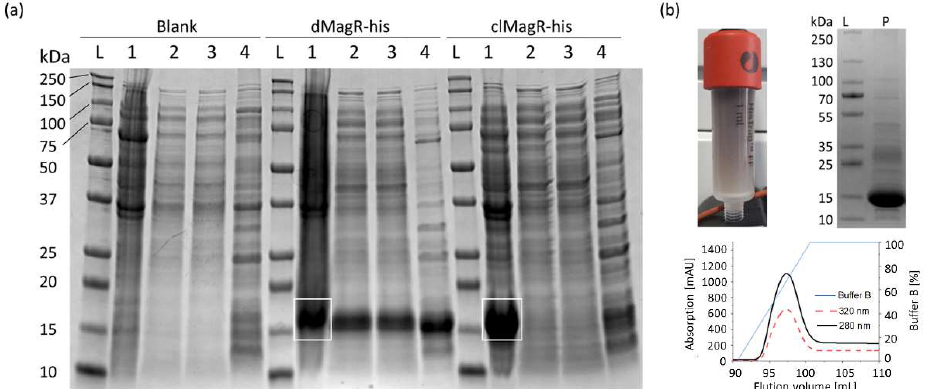
Figure 1. Evaluation of MagR purification from a complex matrix. ( a ) SDS-PAGE analysis of magnetic bead purification of Blank, dMagR-his and clMagR-his from cell disruption supernatant. White rectangles show respective target proteins in the applied cell pellet. Equivalent volumes of sample were applied for each respective lane (1–4). The following samples per lane are seen for each target sample: lane L: protein ladder; lane 1 (3 µ L): solubilized cell pellet; lane 2 (10 µ L): cell-free supernatant after cell disruption; lane 3 (10 µ L): supernatant after magnetite bead precipitation; lane 4 (6 µ L): bead-precipitated proteins after washing of beads. ( b ) Purification of dMagR-his and clMagR-his by IMAC. Coloration of IMAC column of dMagR-his is shown together with IMAC elution profile and the respective SDS-PAGE analysis of the elution pool. SDS-PAGE shows the standard protein ladder in lane L and 10 µ L of the respective IMAC elution pool in lane P. Elution profiles of IMAC show absorption at 280 nm (black line), absorption at 320 nm for iron–sulfur cluster proteins (red dashed line) and relative concentration of elution buffer B (blue line).